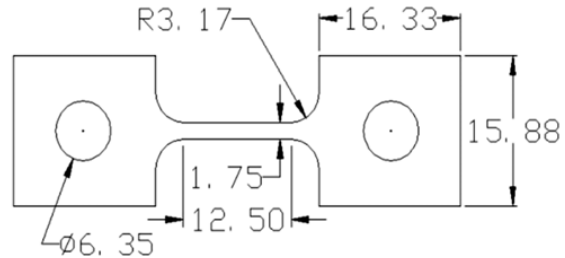
Fig. 2. Miniature dog-bone specimen (dimensions are in mm).